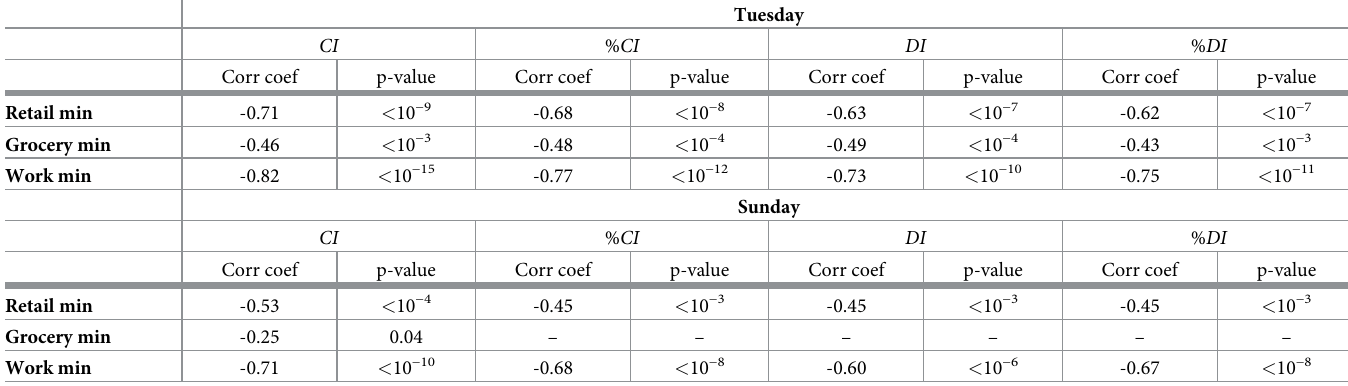
Table 2. Spearman correlations between measures of epidemic size and weekly measures of social mobility in New York counties at the time of PAUSE. The epidemic measures are: cumulative incidence for each county ( CI , columns 1 an 2); percent cumulative incidence (% CI , columns 3 and 4); daily incidence ( DI , columns 5 and 6); per- cent daily incidence (% DI , columns 7 and 8). The lowest mobility levels to Retail, Grocery and Workspace were computed separately for each day of the week; the table shows the results for correlations with Tuesday and Sunday time series. The correlations with daily incidence DI and % DI were based on values from the window smoothed time series; the corresponding correlations based on raw time series were very